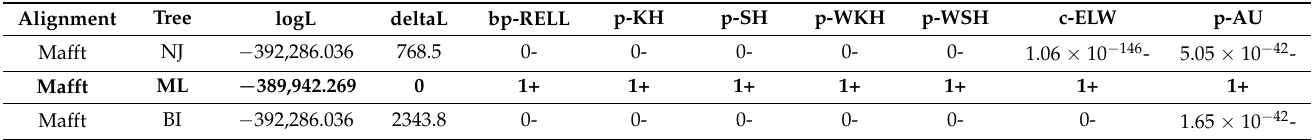
Table 4. Topology comparison for the phylogenetic methods for the capsid gene of PBVs using all 422 complete gene sequences available at the GenBank database. (Best topology detected is highlighted in